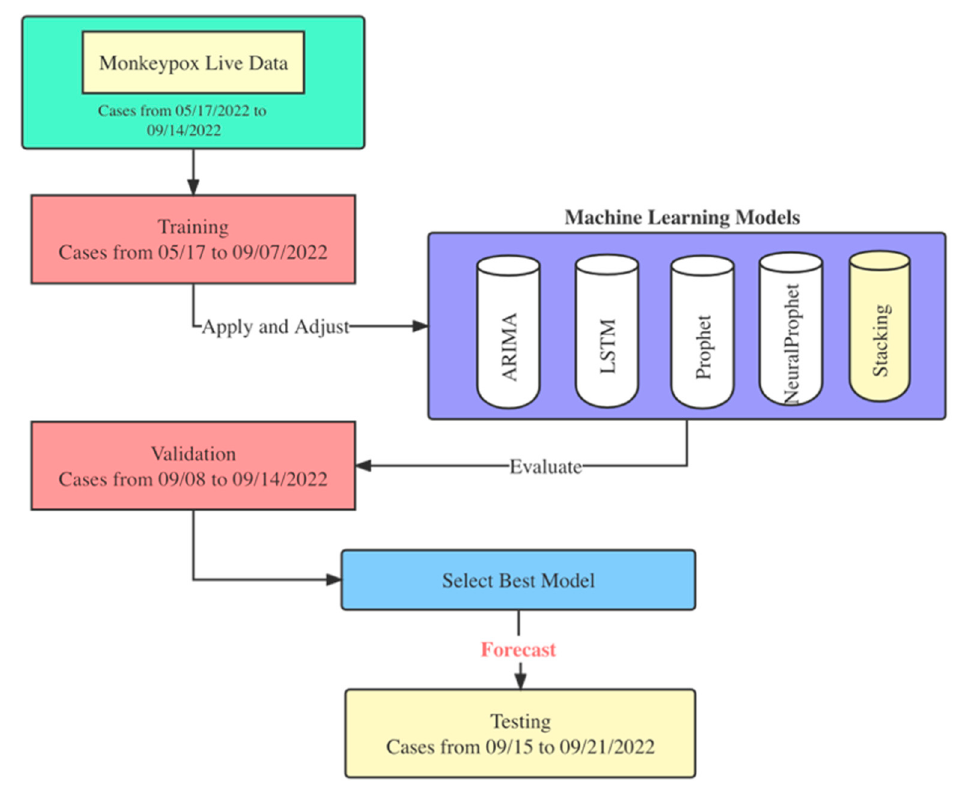
Figure 1. Object process diagram of Monkeypox comparative analysis.